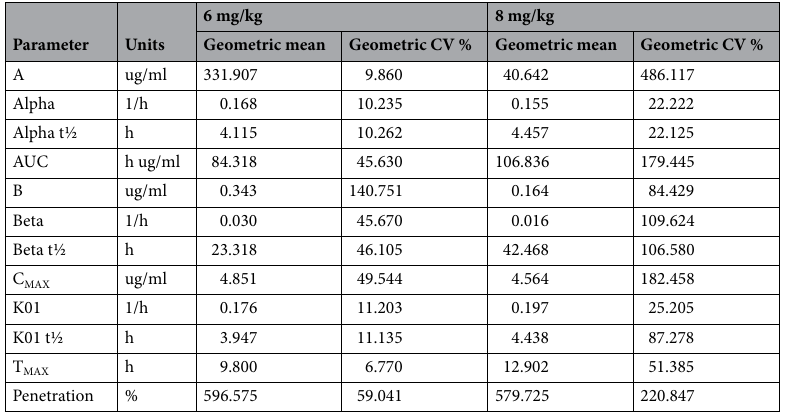
Table 4. Pharmacokinetic parameters for danofloxacin in spiral colon ultrafiltrate dosed at 6 mg/kg under the skin every 48 h for two doses and 8 mg/kg under the skin once. A, B, the intercept for the initial and terminal portions of the curve, respectively. Alpha (α) and beta (β) are the rate constants for the initial and terminal portions of the curves, with their respective half-lives (t½). K01 is the absorption rate and corresponding half- life (t½). C MAX maximum drug concentration, T MAX time to maximum drug concentration.